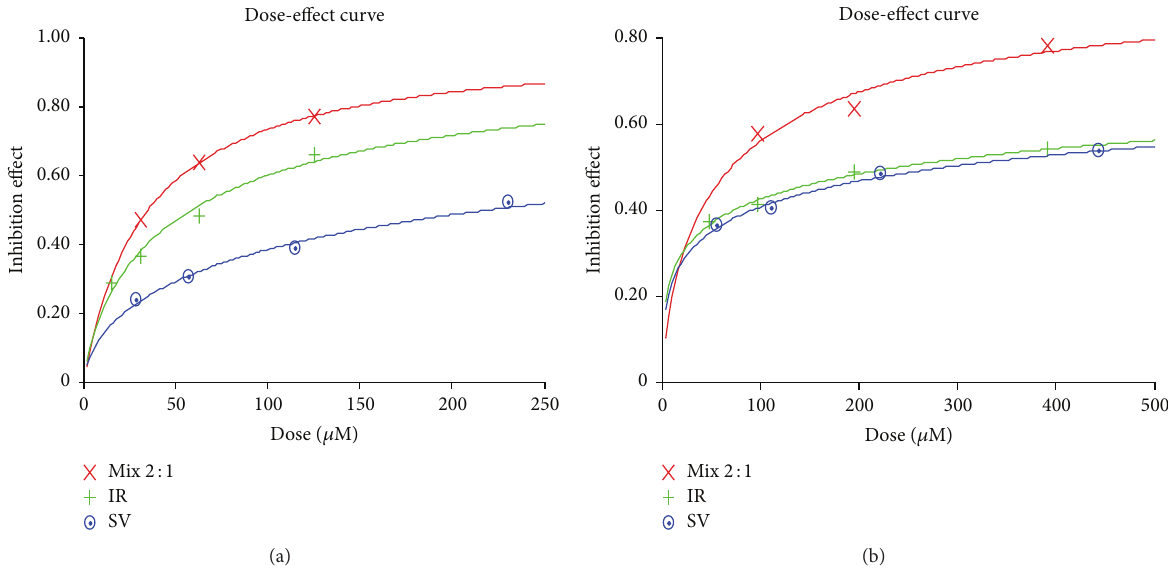
Figure 4: Dose-effect curve of simvastatin and irinotecan in HT-29 cells and HT-29R cells. Combination analysis was done using the method described by Chou and Talalay as described in Section 2. A representative experiment result (repeated at least three times) is reported. Dose- effect curves showed that the combination of simvastatin (SV) and irinotecan (IR) at 2 :1 ratio is significantly potent rather than SV or IR alone in HT-29 cells (a) and HT-29R cells